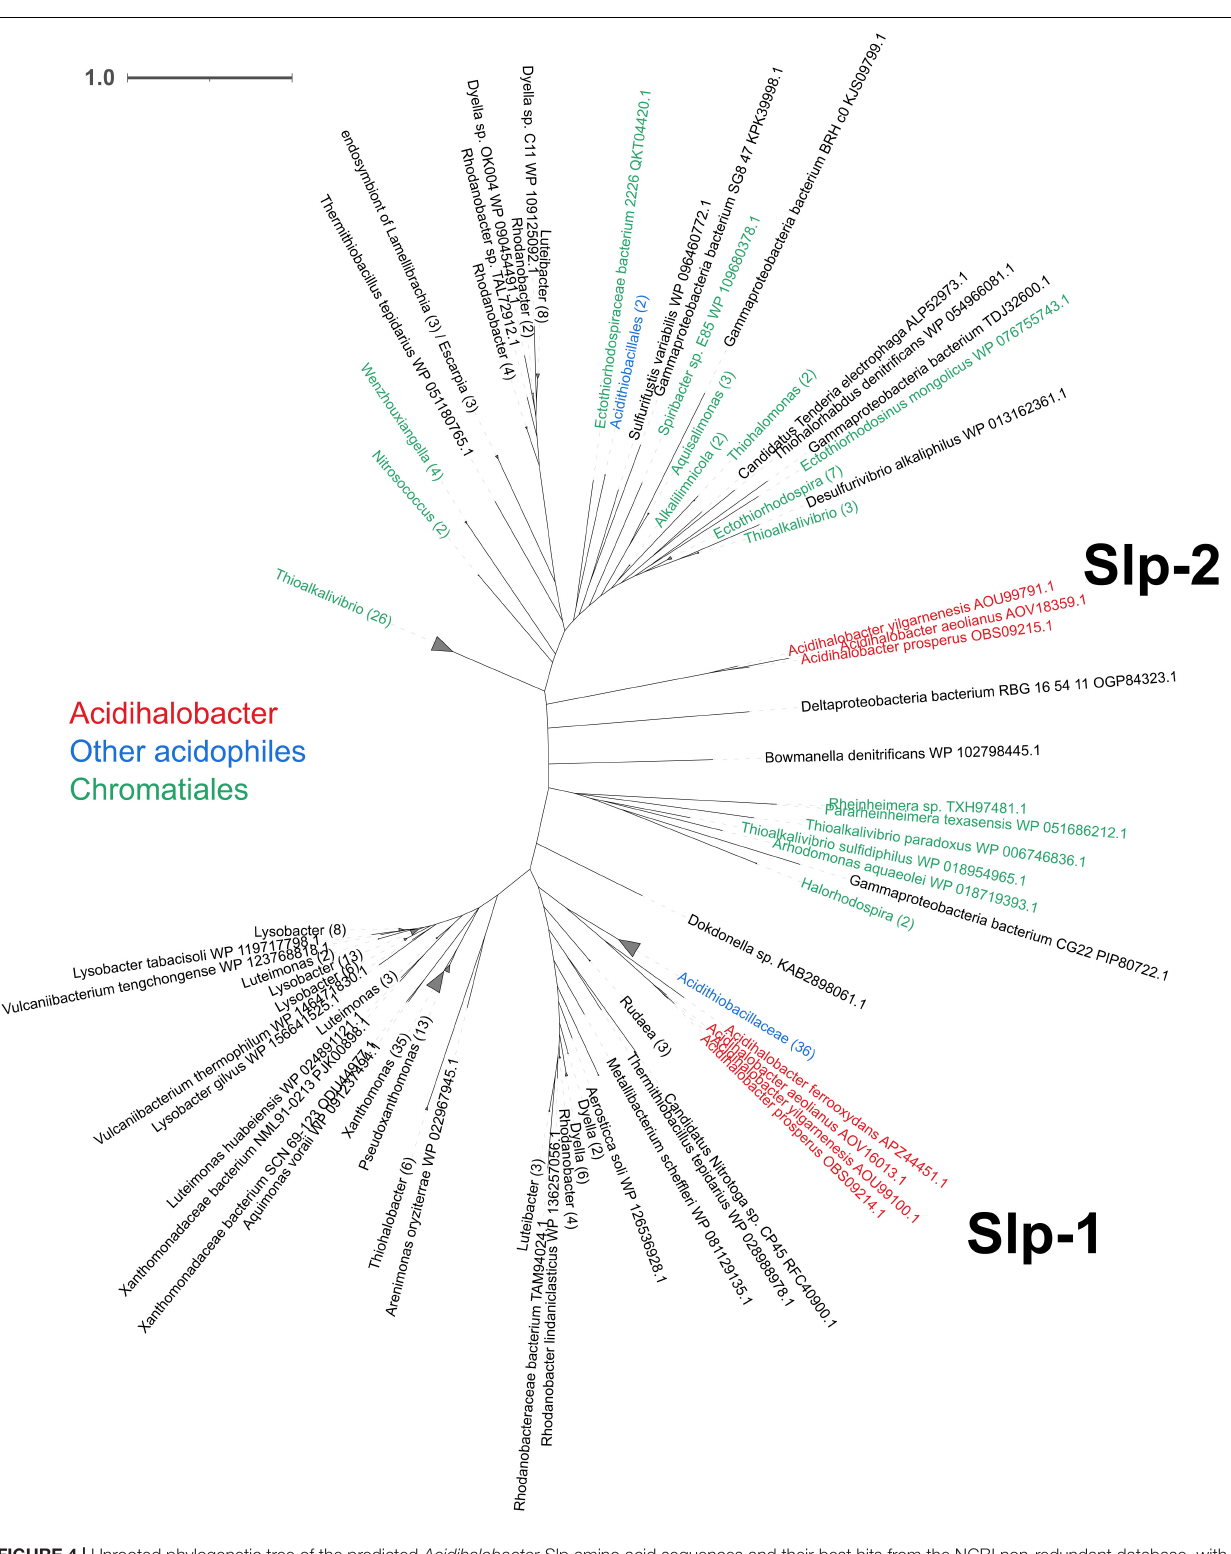
Frontiers in Microbiology |